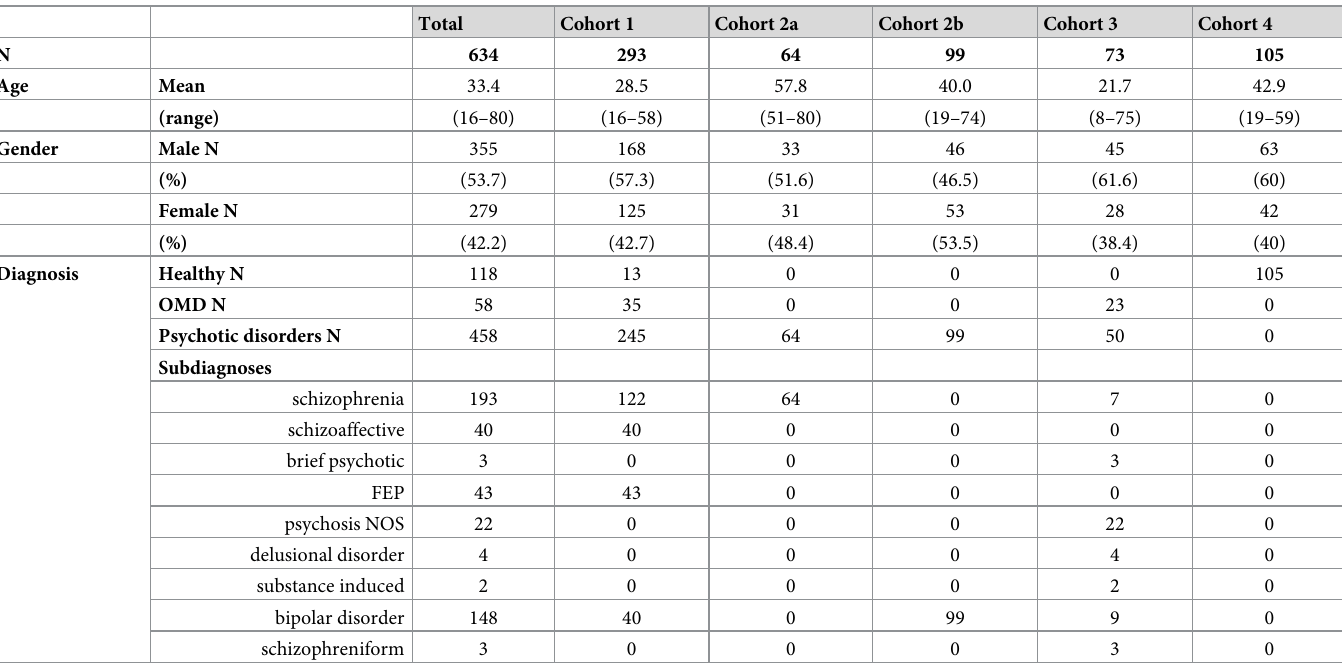
Table 1. Demographic data of the studied